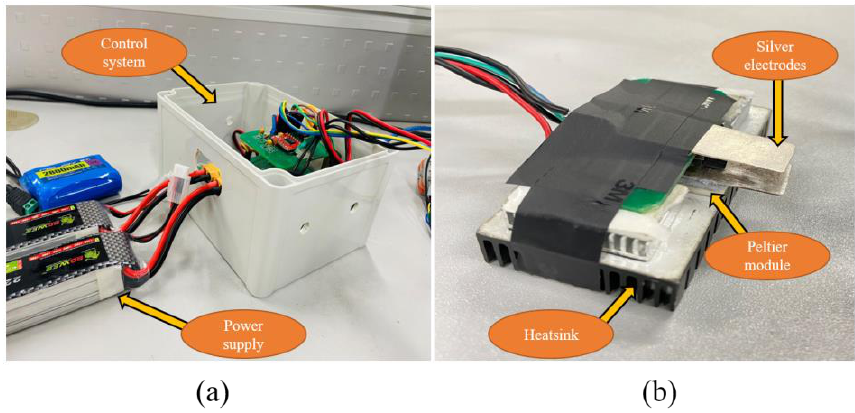
Figure 1. Digital taste system ( a ) implementation and ( b ) system architecture.